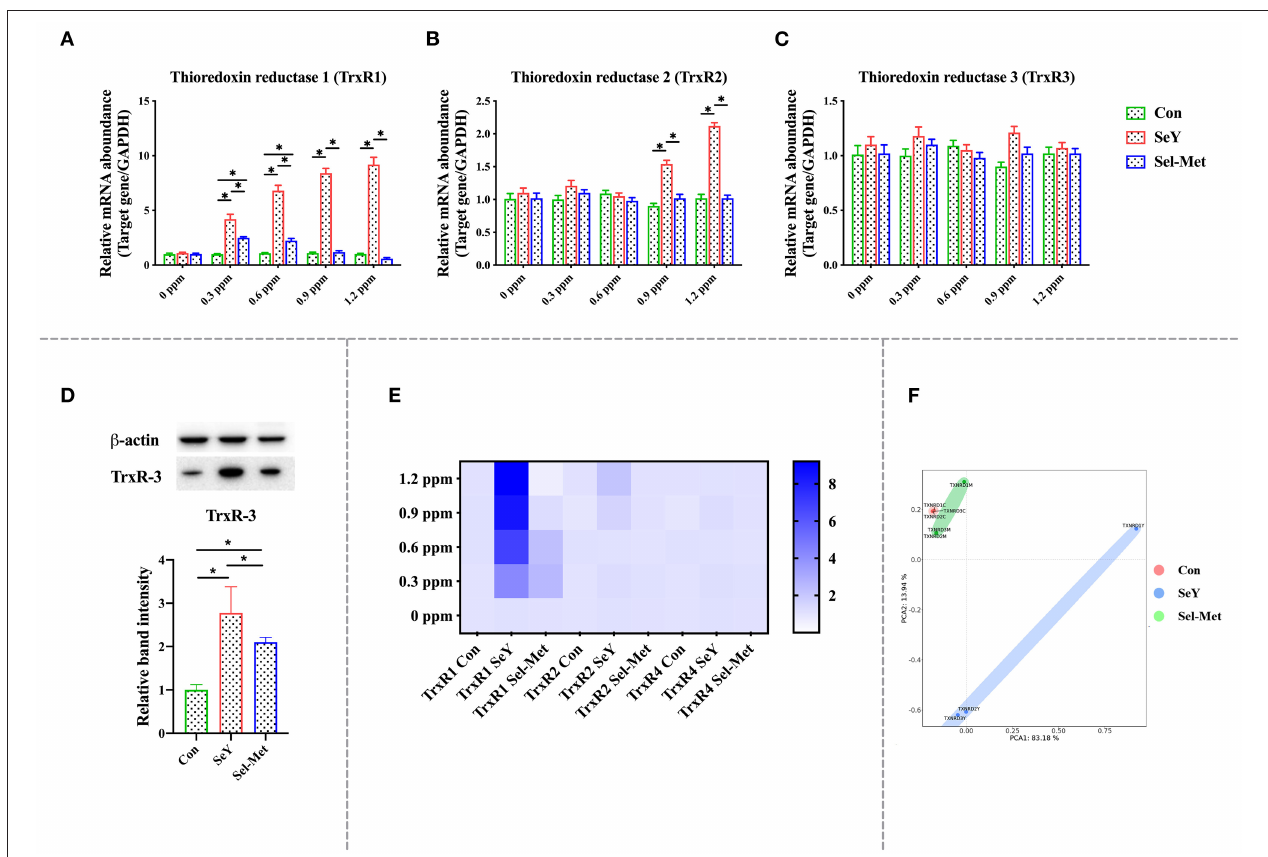
FIGURE 4 | Effects of SeY and Sel-Met addition on mRNA expression of TrxRs family in pMECs. The cells were incubated with different concentrations of SeY and Sel-Met (0, 0.3, 0.6, 0.9, and 1.2 ppm) for 24h, respectively, and then collected for detection. Data were expressed as mean ± SEM ( n = 6), and * indicated statistically significant difference ( P < 0.05). (A–C) mRNA expression level of TrxRs family was detected by qPCR. (D) The relative protein levels of TrxR3 were analyzed by Western blotting. (E) Heat map comparison of TrxRs mRNA expression levels. (F) PCA score plot results compared the mRNA expression of the